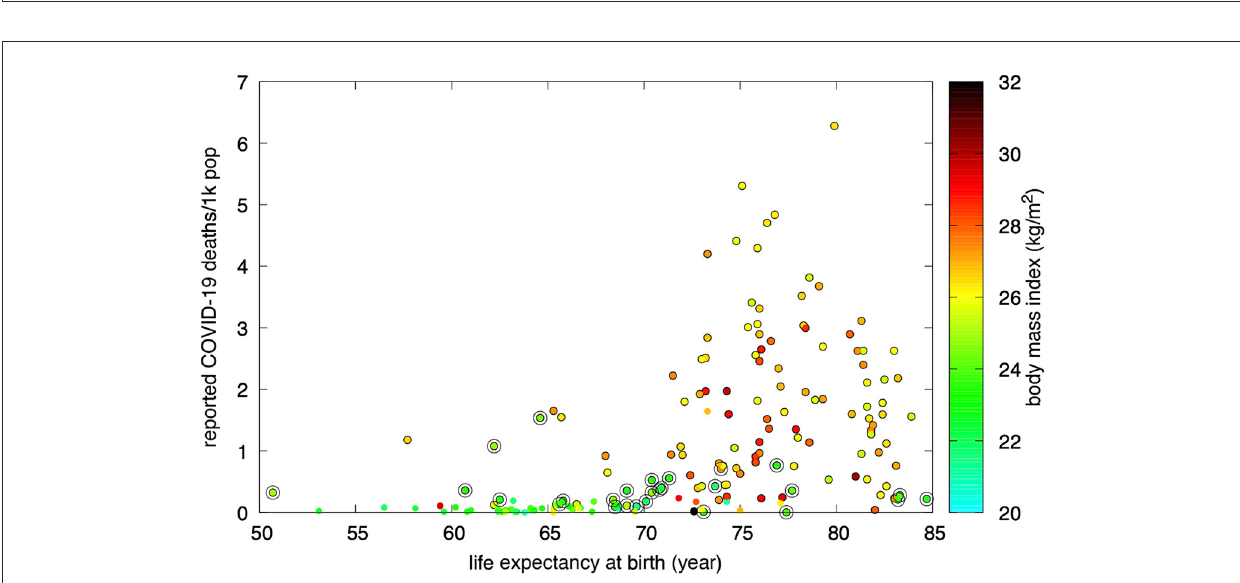
FIGURE3 Countries with a normal mean BMI (circled) reported a lower COVID-19 mortality. Purportedly under-reporting countries are shown with edgeless